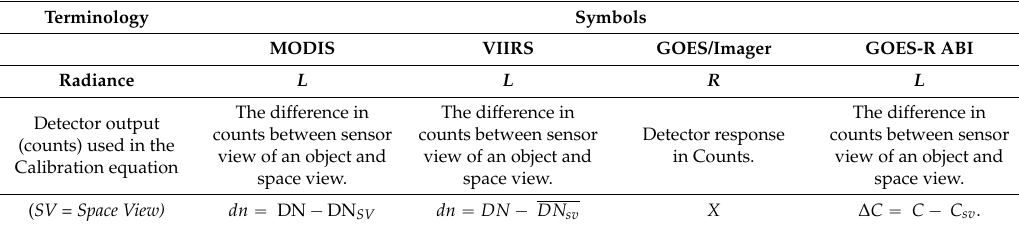
Table A1. Few differences in symbols, terminology and methodology across